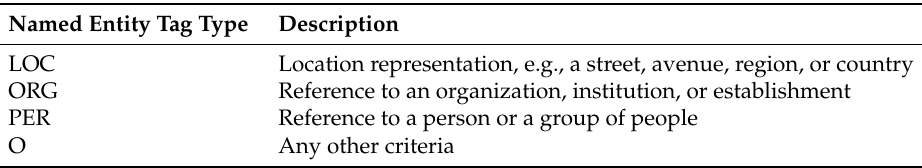
Table 3. Entity tags used for classification.